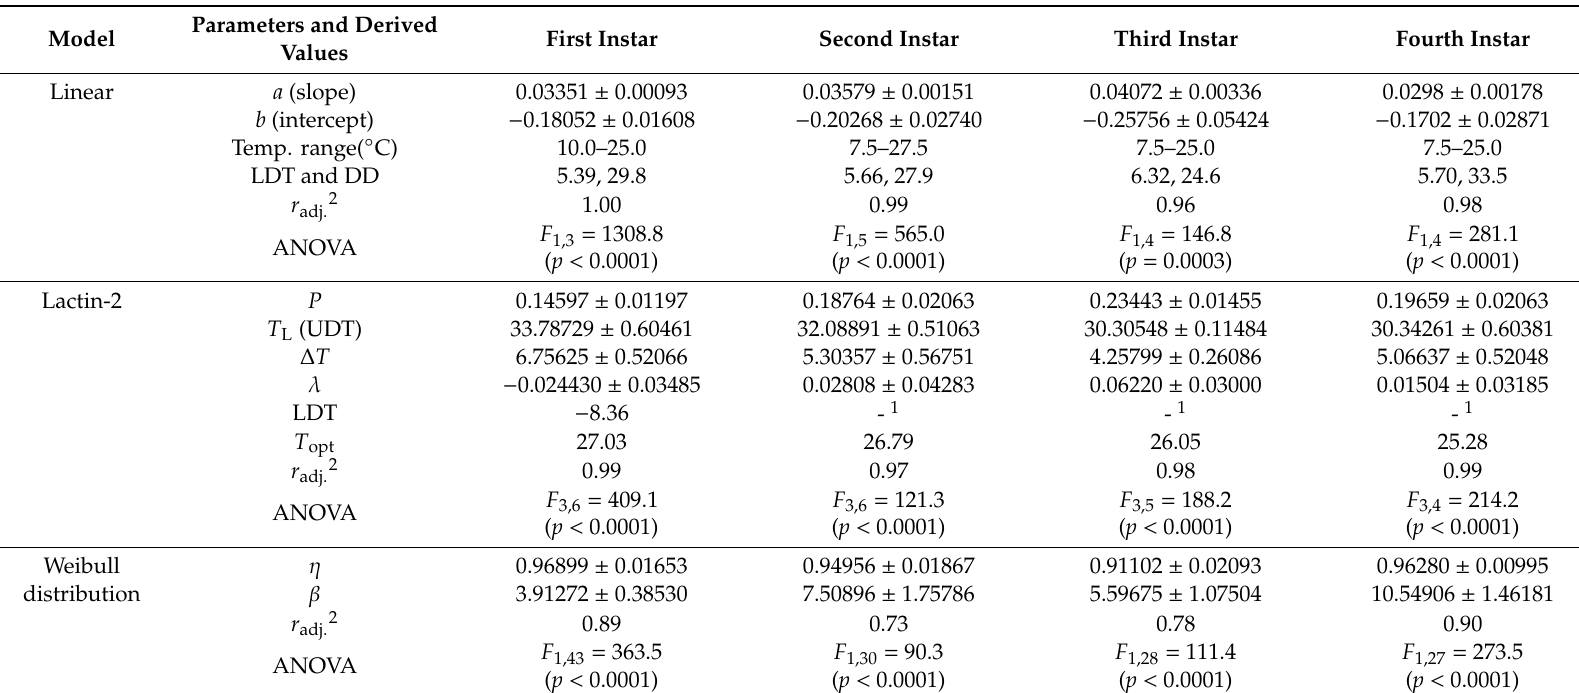
Table 4. Parameters and values derived from the linear and nonlinear temperature-dependent development models in separate instars of A. solani nymphs.